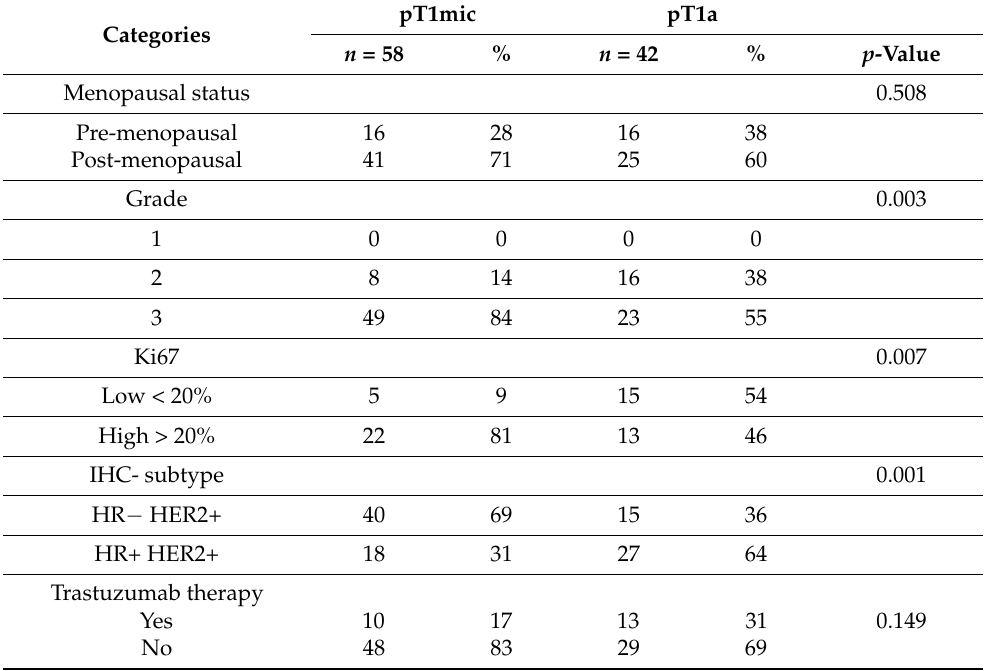
Table 2. Comparison between pT1mic and pT1a subgroups.